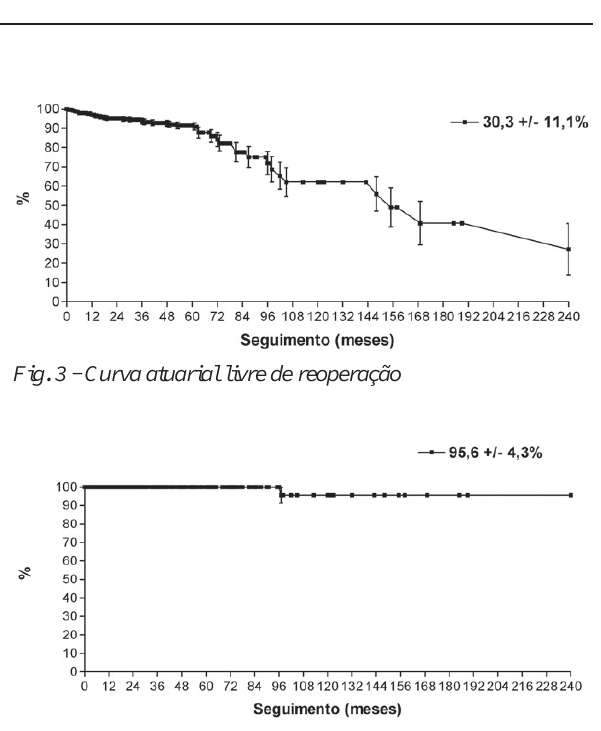
Fig. 4 - Curva atuarial livre de